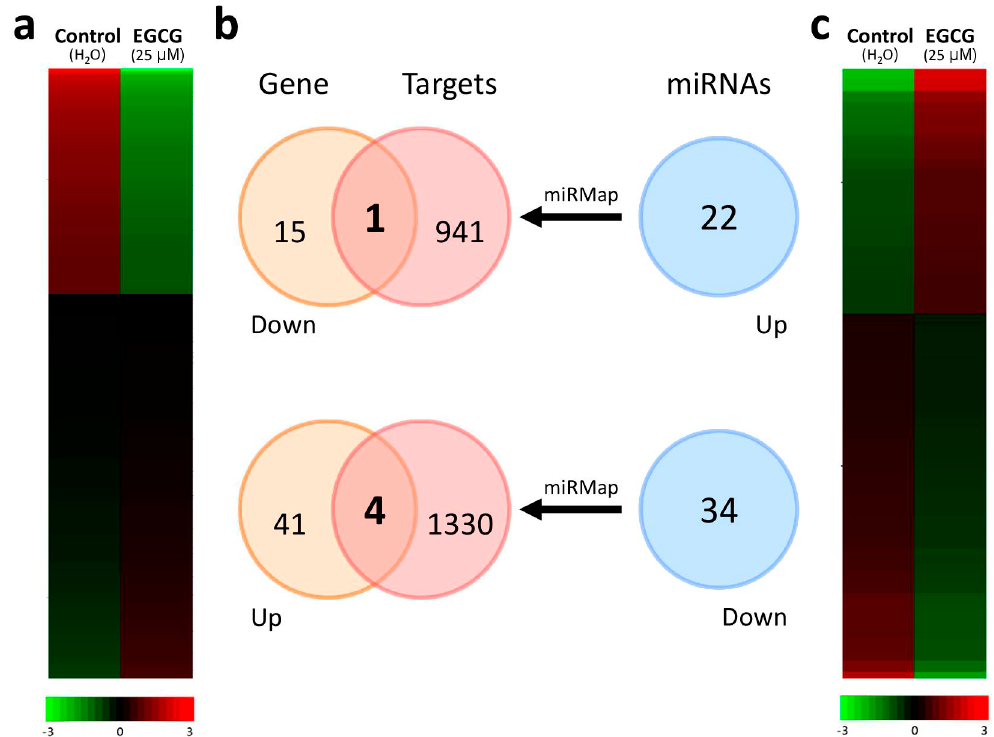
Figure 2. Differentially expressed genes and microRNAs with potential microRNA–target gene 120 interactions identified in idiopathic pulmonary fibrosis (IPF) fibroblasts treated with 121 epigallocatechin gallate (EGCG). A total of (a) 61 differentially expressed genes and (c) 56 122 differentially expressed microRNAs were identified in the EGCG-treated IPF fibroblasts with 123 next-generation sequencing methods, and the heatmaps according to z-scores are illustrated. (b) 124 Using the miRmap database for microRNA target prediction (selection criteria of miRmap score 125 ≥ 97.0), 942 putative targets of the 22 upregulated microRNAs and 1334 putative targets of the 34 126 downregulated microRNAs were identified. Matching to the 16 downregulated genes and 45 127 upregulated genes identified in the EGCG-treated IPF fibroblasts, the intersection Venn diagram 128 identified five potential microRNA–mRNA interactions (as shown in Table 1). 129 Table 1. Potential altered miRNA–mRNA interactions in idiopathic pulmonary fibrosis (IPF) 130 fibroblasts treated with epigallocatechin gallate (EGCG). 131 Gene miRNA